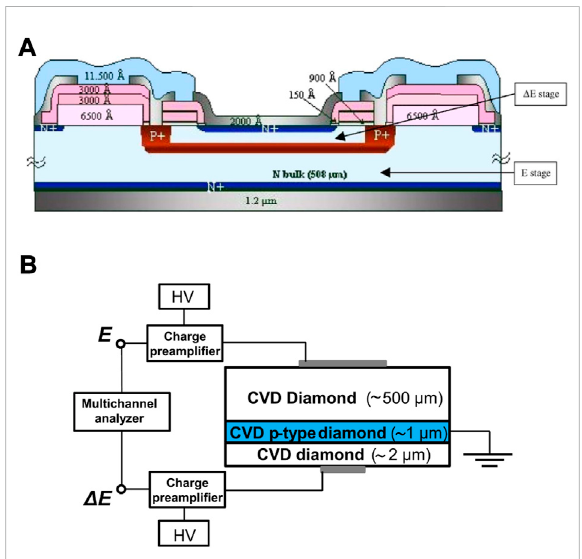
FIGURE 13 Silicon-based and diamond-based telescope structures. (A) Schematic representation of the silicon-based Δ E − E telescope microdosimeter.Source:[118]. (B) Schematiccrosssectionviewof thediamond-basedtelescopewithindicationoftheread-out electronics. Source: